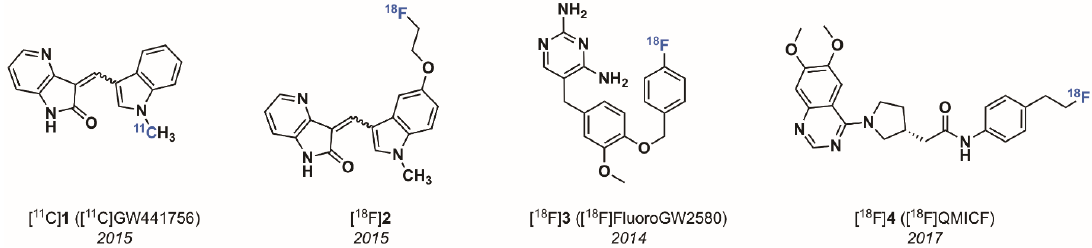
Figure 3. Chemical structures of early Trk-targeted positron emission tomography (PET) radioligands.